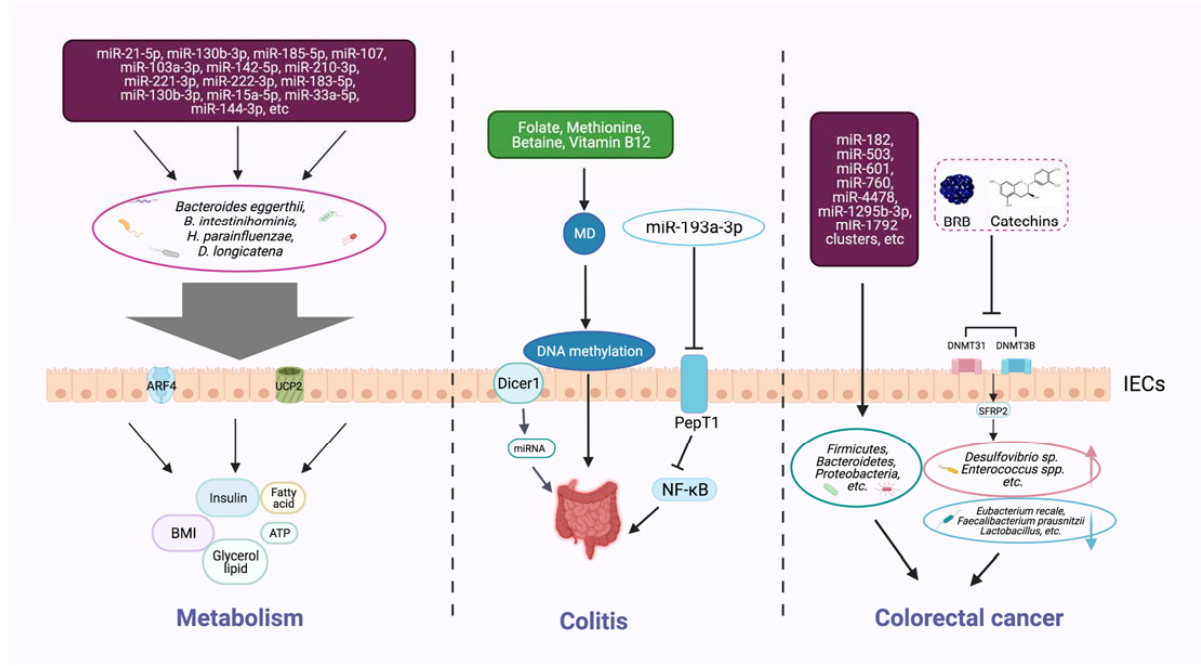
Figure 2. Host epigenetic factors regulate the gut microbiota in multiple progresses of diseases. The gut epithelium secretes a variety of miRNAs, which can enter microorganisms to affect their transcription and alter the microbial structure and diversity. The gut microbiota generates different metabolites (e.g., butyrate and bile acids) that can, in turn, regulate the host metabolism, including BMI, insulin secretion, and lipid production. Dietary intake of nutrients (e.g., folic acid, me- thionine, and vitamin B12) provides methyl donors that affect host DNA methylation, which may modulate the intestinal inflammatory state. Some microbial metabolites can modify DNA methylation, histone acetylation, and miRNAs, and impair the homeostasis of the intestinal environment, thereby reducing beneficial microbiota and increasing the richness of pathogenic bacteria, and inducing the development of colorectal cancer.